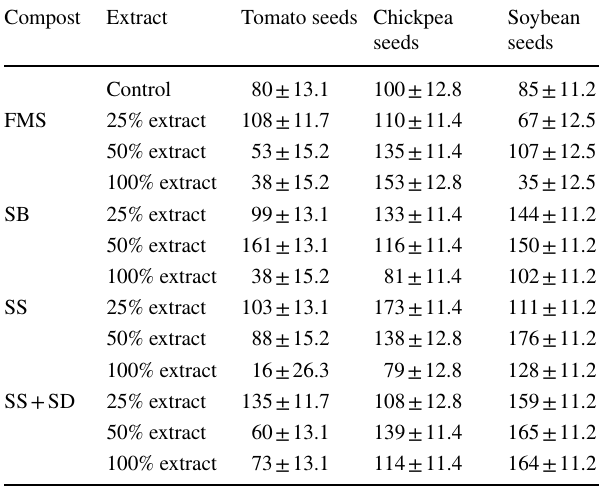
Table 4 LS Means for GI of composts obtained from straws of sor- ghum (SS), finger millet (FMS), soybean (SB) and sorghum + saw dust (SS + SD) when tested with tomato, chickpea and soybean